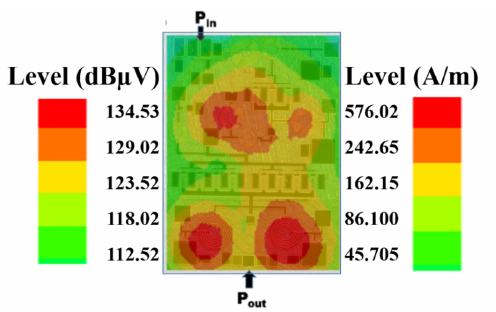
Figure 6. Magnetic field distribution obtained through HFSS simulation over the gallium nitride high electron mobility transistor (GaN-HEMT) power amplifier IC at 3 GHz operating frequency.